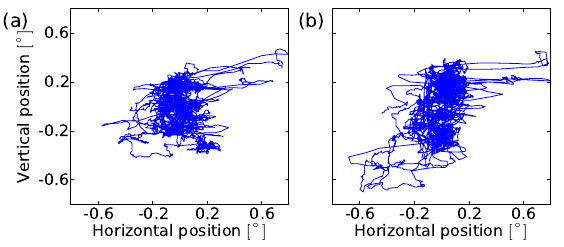
Figure 4 . Representation of the trajectories in a fixational eye movement trial for both eyes. Recorded with EyeLink II sys- tem we obtained the horizontal (x-axis) and vertical (y-axis) position of (a) left and (b) right eye. The trajectories are cor- rected to center.